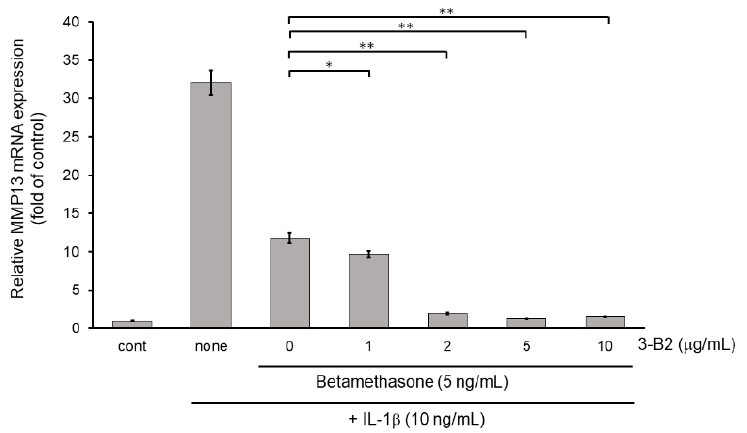
Figure 11. Additive effect of 3-B2 on attenuating MMP13 mRNA expression with low dose of betamethasone in IL-1 β -treated OUMS-27 cells. Cells were pretreated with various concentrations (1, 2, 5, 10 µ g/mL) of 3-B2 and with betamethasone (5 ng/mL), followed by the stimulation with IL-1 β (5 ng/mL) for 6 h. Along with low dose of betamethasone, 3-B2 exhibited significant additive attenuating effect on MMP13 mRNA expression in IL-1 β -stimulated OUMS-27 cells. Values represent mean ± SE ( n = 6 per group). * p < 0.05 and ** p < 0.01, respectively.